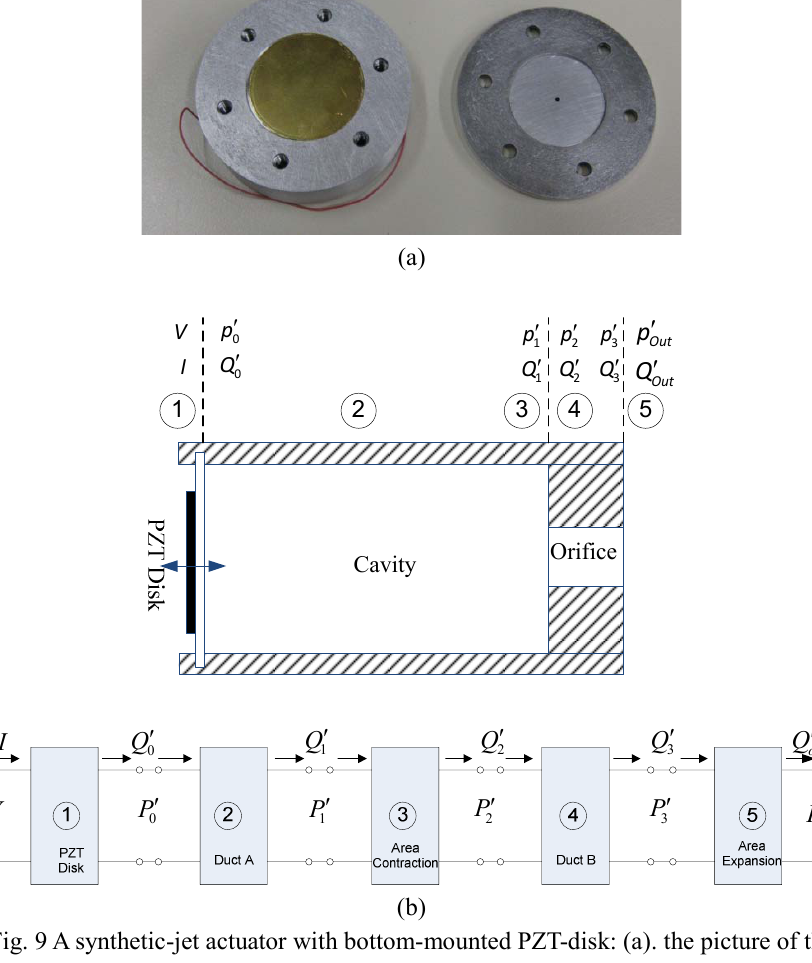
Fig. 9 A synthetic-jet actuator with bottom-mounted PZT-disk: (a). the picture of the disassembled actuator; (b). the schematic used to derive the TM of the actuator. 3.1 Transfer matrix of synthetic-jet actuators with a bottom-mounted PZT